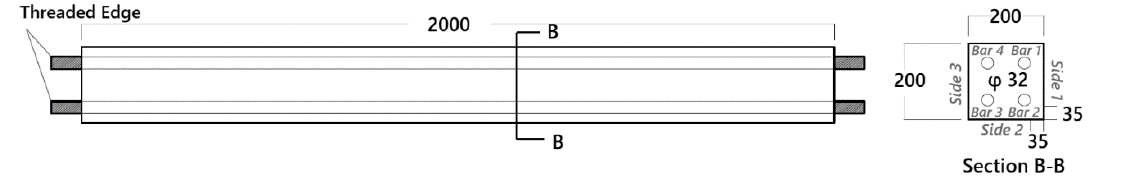
Figure 13. CPM case example showing the stress distributions and crack sequences along the model axis for different stress levels.